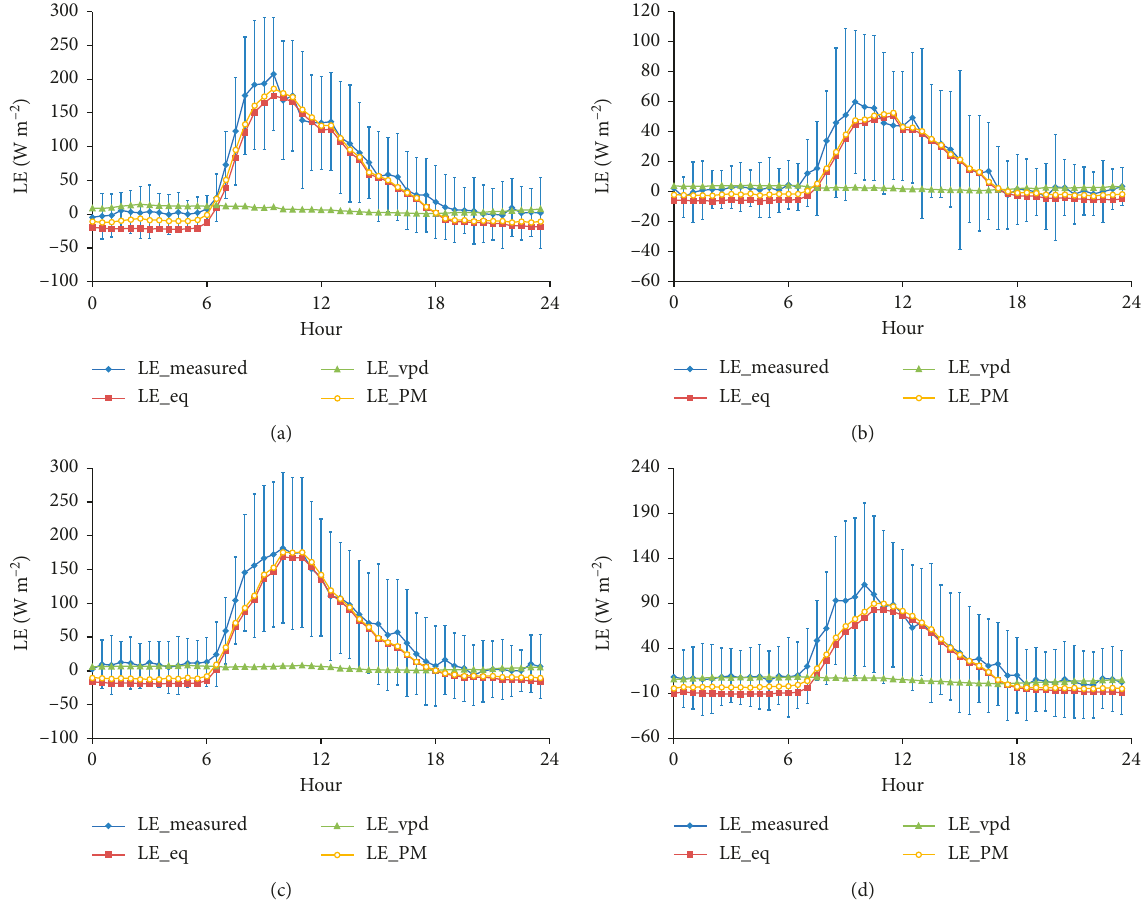
Figure 7: Diurnal variations of measured LE (LE_measured), LE predictions by PM equation (LE_PM), LE at equilibrium (LE_eq), and the LE contribution by vpd (LE_ vpd ) for the season of (a) warm 2005, (b) cool 2005, (c) warm 2006, and (d) cool 2006. The vertical bars indicate the standard